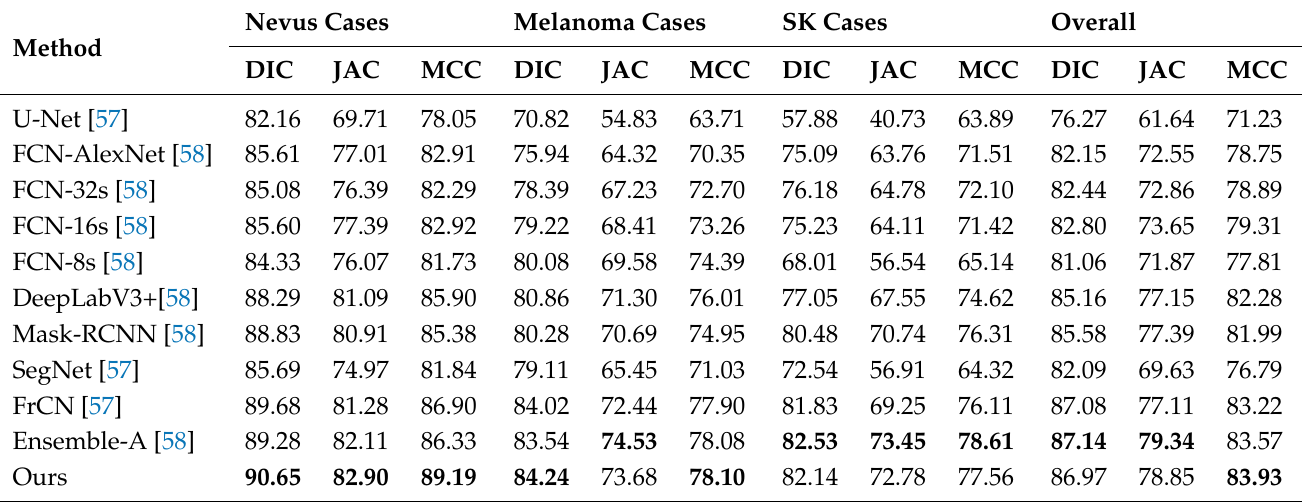
Table 10. Performance evaluation of Jaccard coefficient, Dice coefficient and Matthew correlation coefficient of different modules and CSFAG modules on the ISIC-2017 data set. Bold data indicates that the value is the maximum value in this